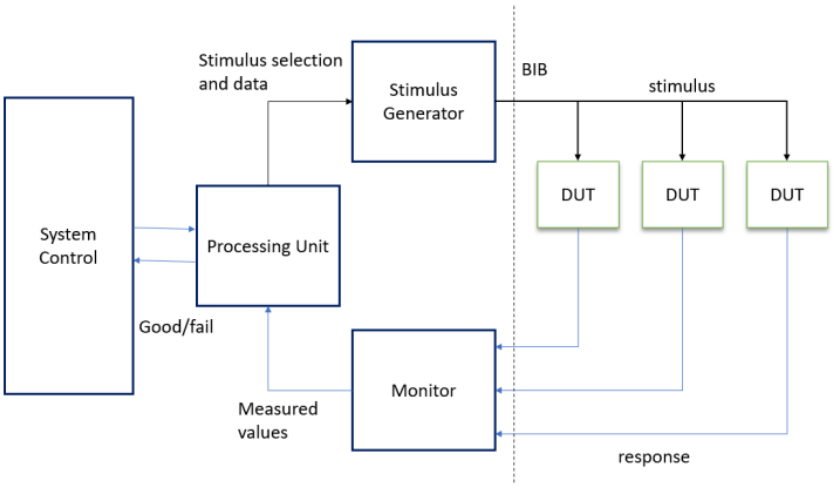
Figure 9. Massive Parallel Test (MPT) architecture.